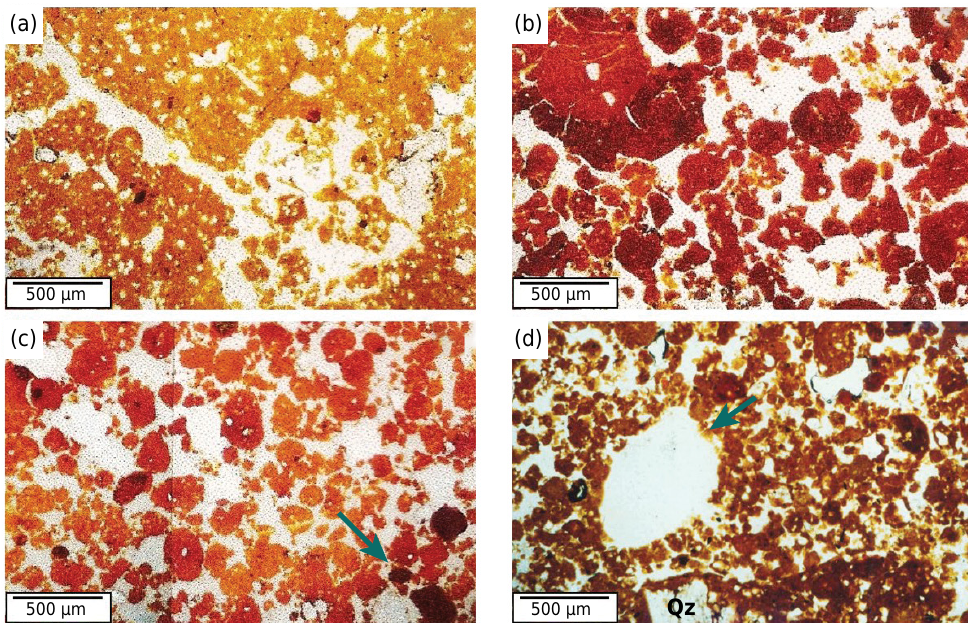
Figure 5. Photomicrographs of the Ap horizon (a), BA horizon (b), Bw 2 horizon (c), and Bw 3 horizon (d) in the P 3 - Geric Acric Rhodic Ferralsol (Clayic, Dystric); Serra do Salitre topolithosequence. Ap horizon showing a strongly coalesced granular structure (a), BA horizon showing a typical oxic microstructure (b), with larger aggregates compared with the underlying Bw 2 (the arrow shows a Ti/Fe nodule) (c), and for the Bw 3 horizon, aggregates are significantly smaller with abundant oriented, striated clay plasma, as dispersed clay and biological channels (arrow) (d). Qz: